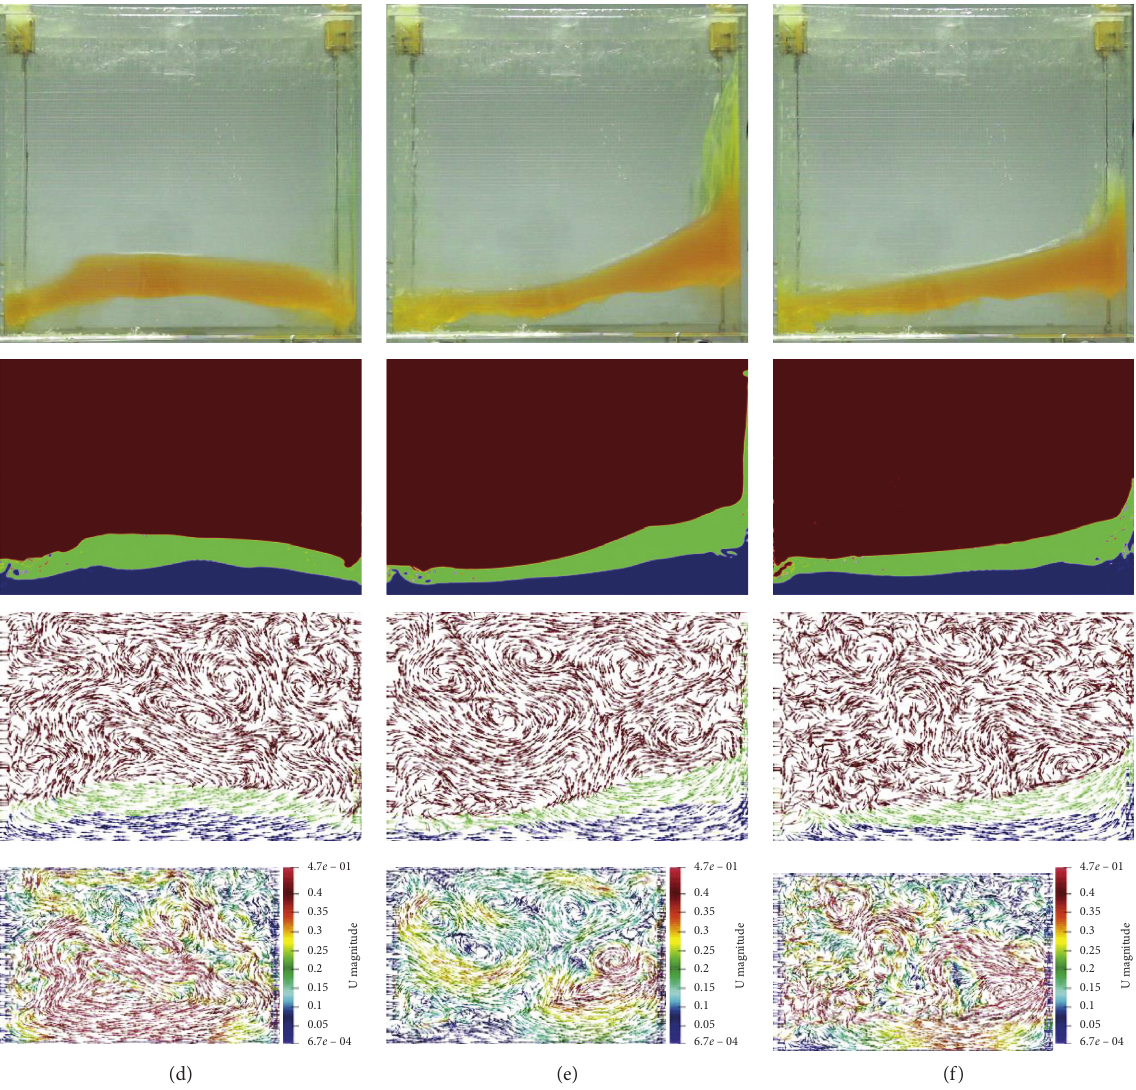
Figure 12: Comparison of free surface and interfacial wave. (a) T � 2 . 00 s. (b) T � 4 . 00 s. (c) T � 6 . 00s. (d) T � 8 . 00s. (e) T � 10 . 00 s. (f) T � 12 . 00